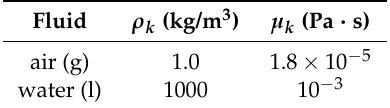
Table 2. Physical properties of the adopted fluids.